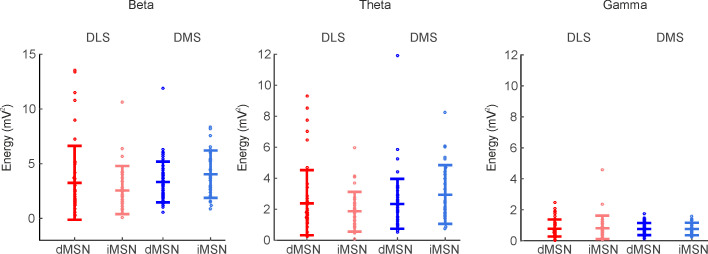
Beta, Theta, and Gamma bands in membrane voltage of direct and indirect pathways in the DLS and DMS.Energy of the Beta, Theta, and Gamma bands of direct and indirect DLS- and DMS-MSNs. p Values obtained using the Wilcoxon Rank-sum test.